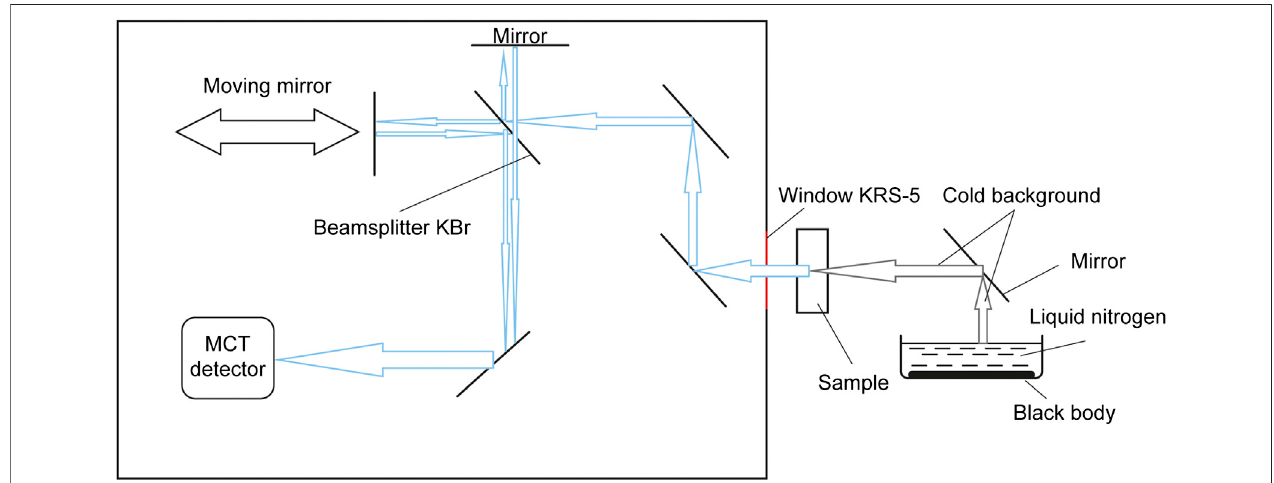
FIGURE 1 | Equipment con fi guration based on a vacuum Fourier transform IR spectrometer for measuring emission spectra.